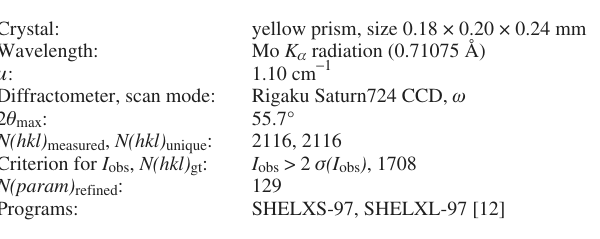
Table 1. Data collection and handling.